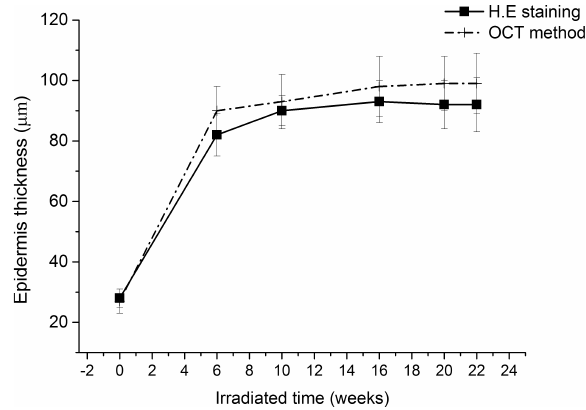
Fig. 2. Measurement of epidermis thickness from H.E. stain- ing method and OCT method.